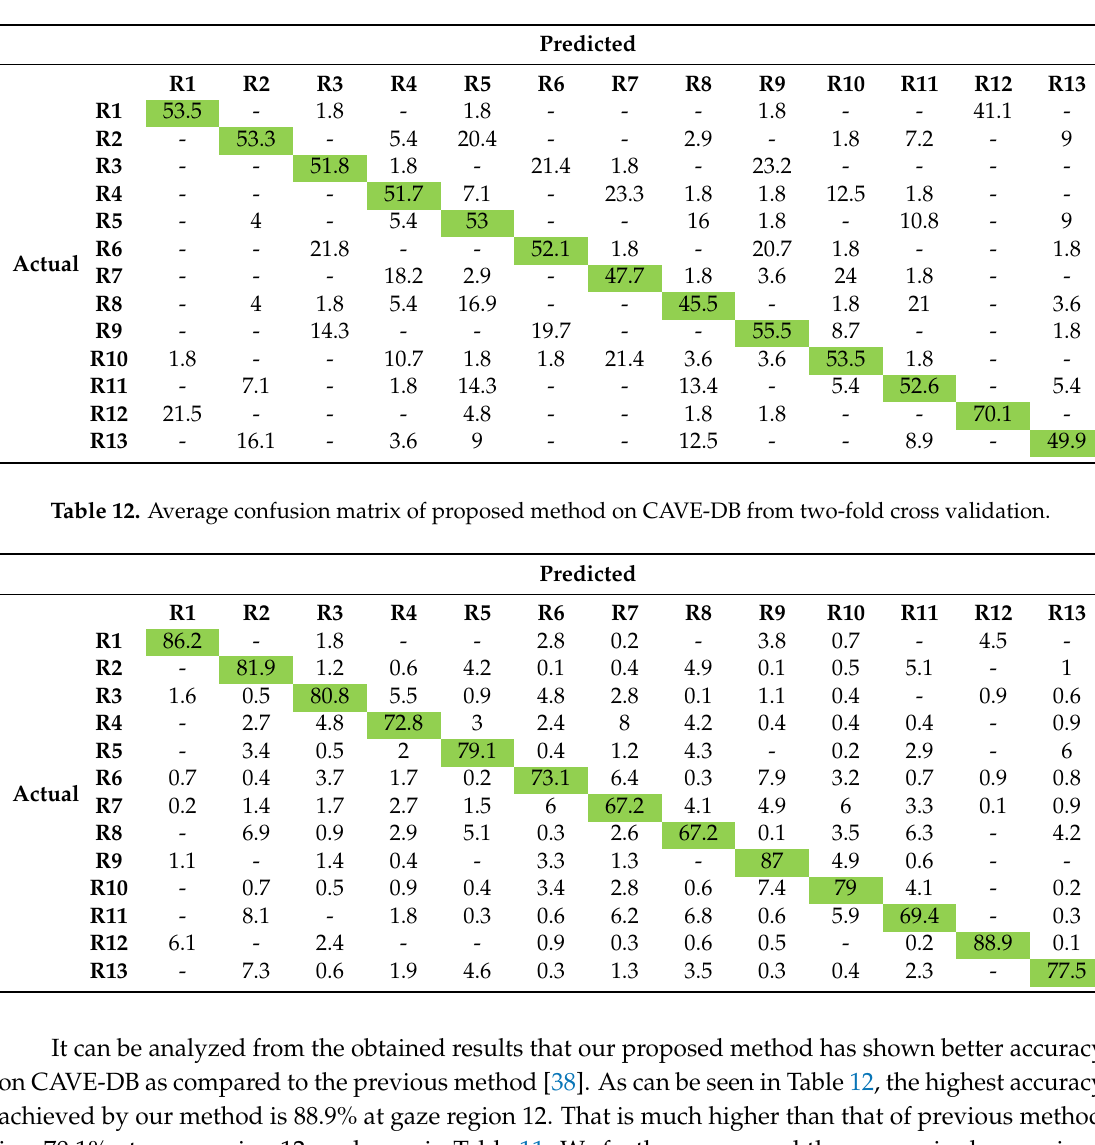
Table 11. Average confusion matrix of previous method [38] on CAVE-DB from two-fold cross validation.